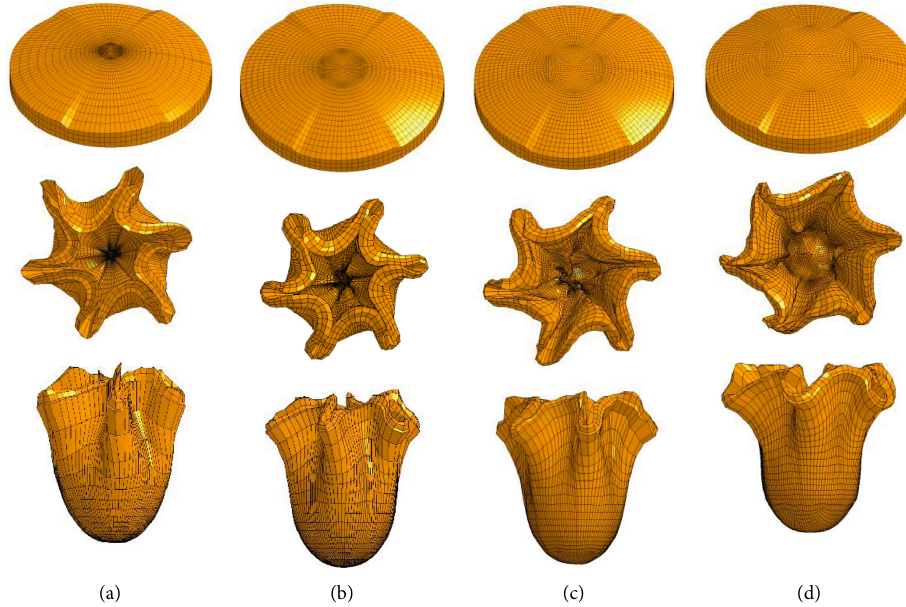
Figure 22: Numerical simulation results of EFP formation for four different spherical arc radii. (a) r � 2.5mm( t � 240 μ s, v r � 5mm( t � 240 μ s, v a � 1403m/s). (c) r � 7.5mm( t � 240 μ s, v a � 1390m/s). (d) r � 10mm ( t � 240 μ s, v a � 1381 m/s).